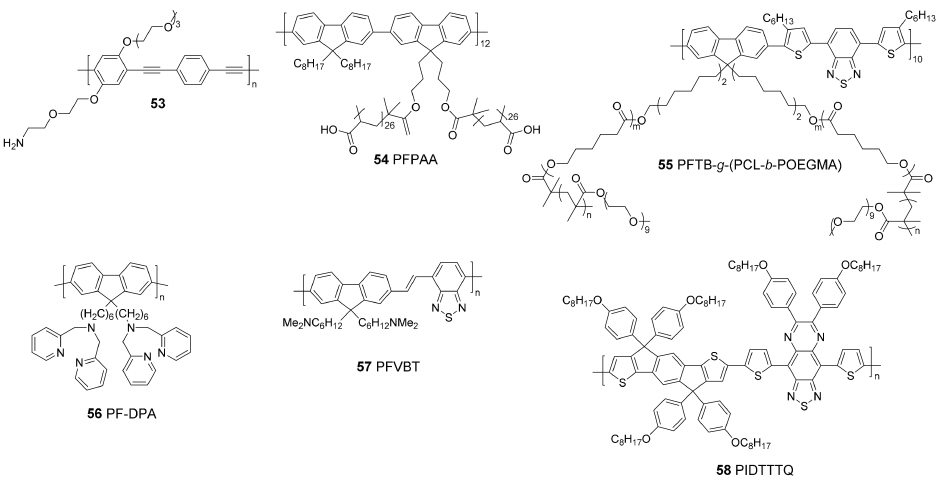
Figure 14. CPs used to form theranostic